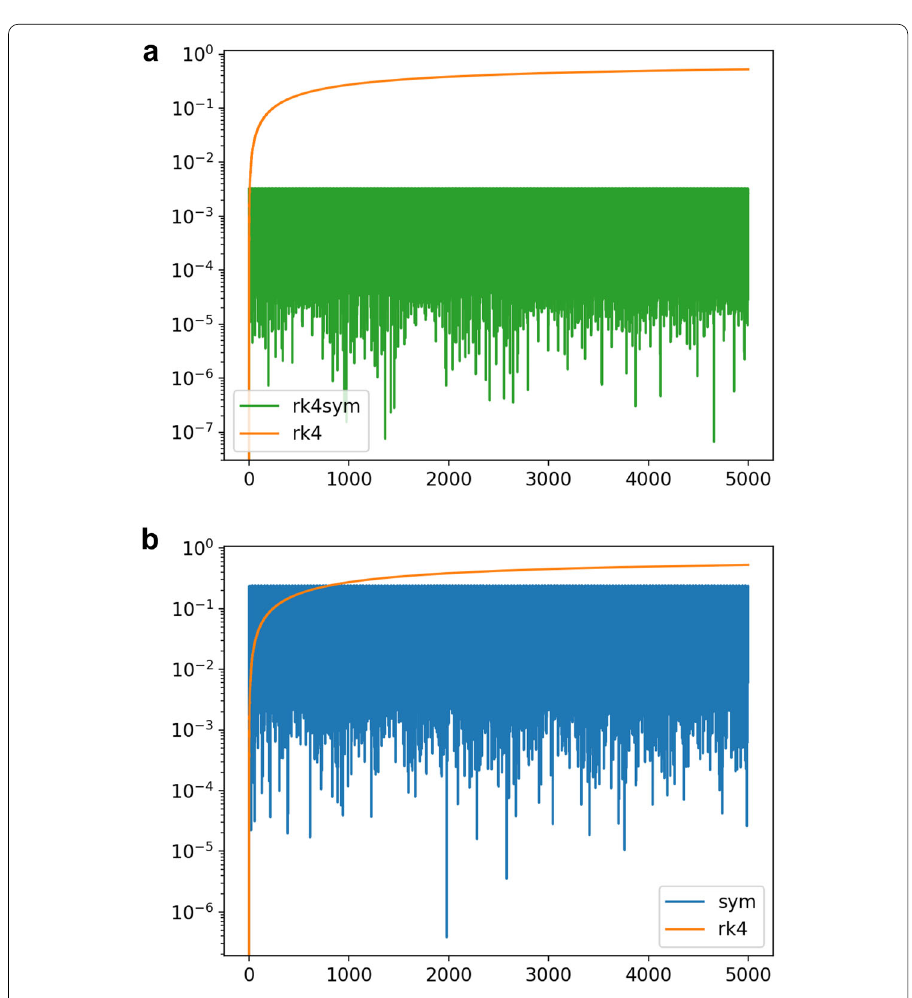
Fig. 3 Toda lattice. Relative error on H with (cid:5) t = 10 − 1 . a RK4 and RK4sym. b RK4 and Symplectic